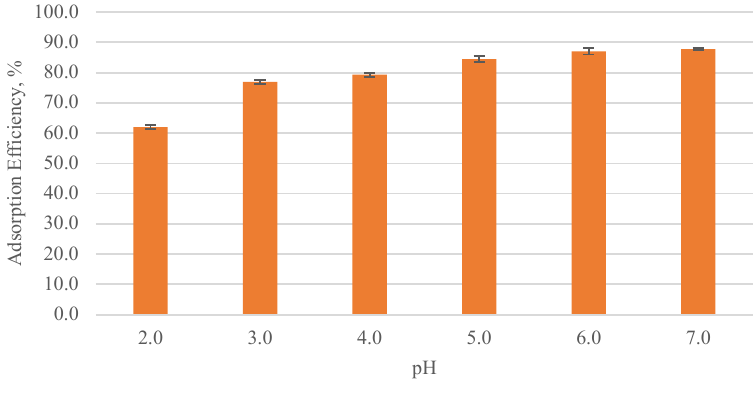
Fig. 1. Relationship between copper (II) ions adsorption efficiency on modified wheat bran and pH of solution, n = 3, ±SD. Adsorption efficiency increased from 76.9 % to 84.5 % at pH 3.0 and pH 5.0, respectively. At pH greater than 5.0, adsorption began to increase sharply. At various pH levels copper